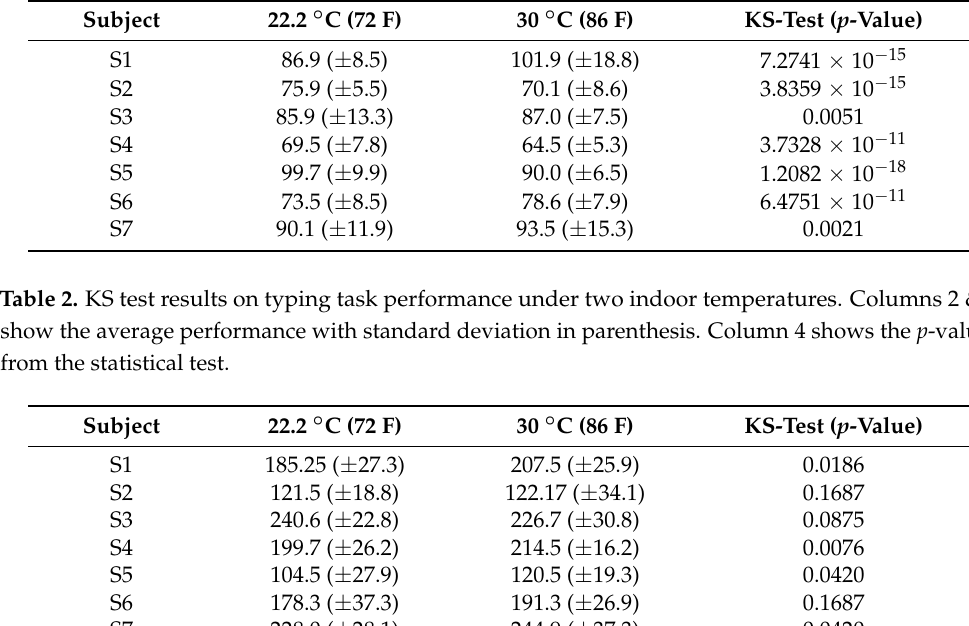
Table 1. Kolmogorov-Smirnov (KS) test results on addition task performance under two indoor temperatures. Columns 2 & 3 show the average task performance with standard deviation in parenthesis. Column 4 shows the p -values from the statistical test.